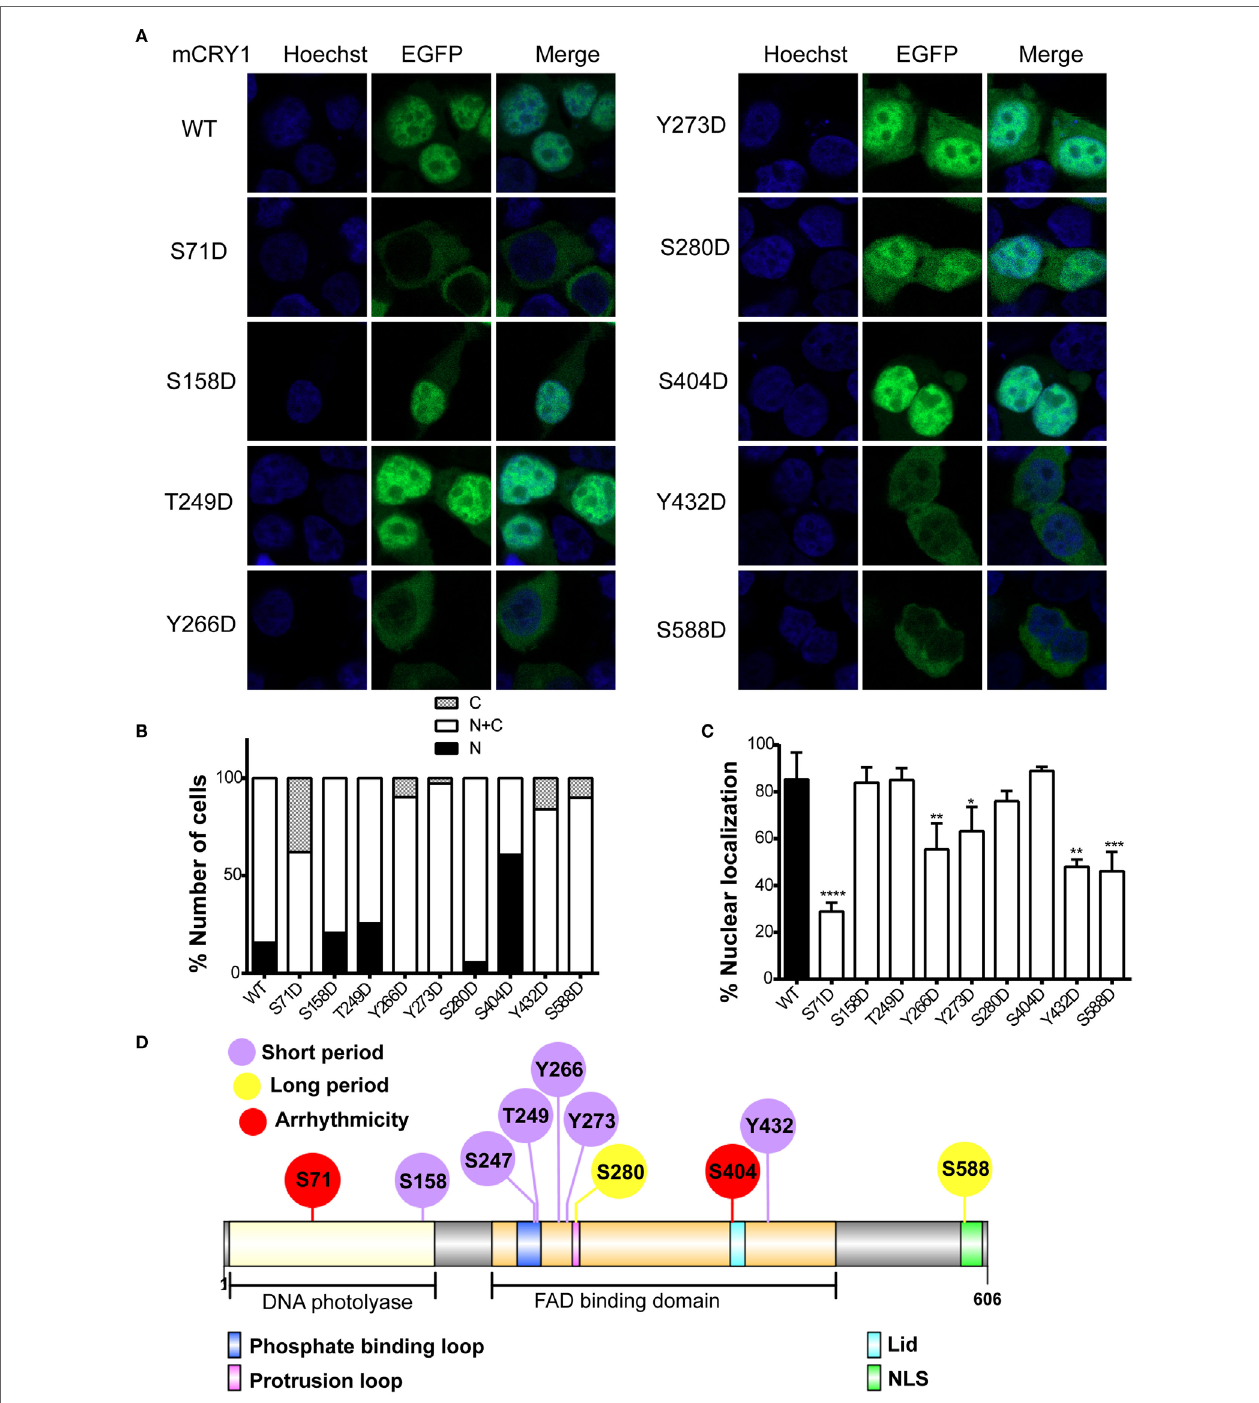
FigUre 4 | effects of phosphomimetic mutation on subcellular localization of mcrY1 protein . GFP-tagged mCRY1 (WT or mutant) proteins were transiently overexpressed in HEK293 cells, and the subcellular distribution pattern of mCRY1 protein was analyzed. (a) Representative images of GFP-mCRY1 (WT or mutant) were detected by GFP fluorescence (green), and the nuclei were stained with Hoechst (blue). (B) Percentage of cells showing nuclear (N), nuclear– cytoplasmic (N + C), and cytoplasmic (C) staining as indicated in the plots. The ratio of cells with subcellular localization to the total transfected cells was analyzed by counting 100 cells three times in each experiment. (c) Percentage of colocalization of GFP-mCRY1 (WT or mutant) with nuclei. The 50 GFP-mCRY1 (WT or mutant)-expressing cells were analyzed by Image J software (Version 1.37c, NIH, USA). Mean and error bars (SEM) are shown ( n = 3 for each experiment). Two additional experiments gave similar results (* p < 0.05; ** p < 0.01; *** p < 0.001; **** p < 0.0001, ANOVA). (D) Location of the important phosphorylated sites on the liner protein functional regions of mCRY1. The FAD binding domain, which contains phosphate binding loop, protrusion loop, C-terminal lid (Lid), and nuclear localization signal (NLS), has been indicated in this schematic diagram. The diagram was constructed using Illustrator for Biological Sequences (IBS) software